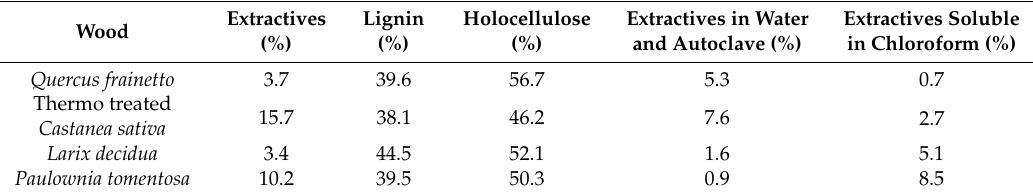
Table 1. Extractives, lignin, and holocellulose contents in wood samples. Wood Quercus frainetto